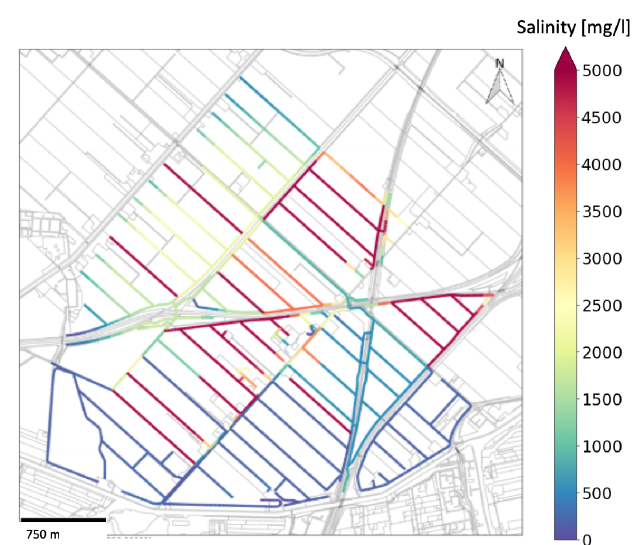
Figure 3. The spatial variation of salinity in the Lissertocht catchment for a snapshot (daily average of 15 July 2012) taken from the reference scenario; modeled with the SOBEK model.